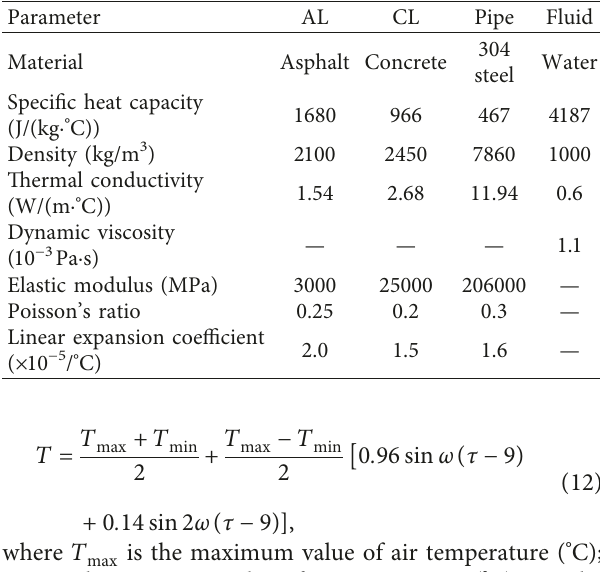
Table 1: Thermal parameters and elastic parameters of